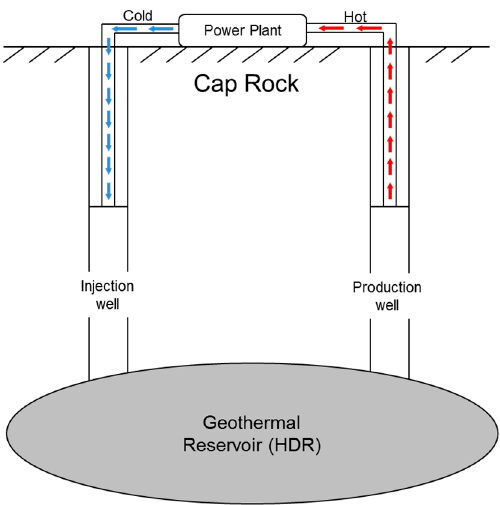
Figure 1. Ideal hot dry rock production scheme for Enhanced Geothermal System (EGS).